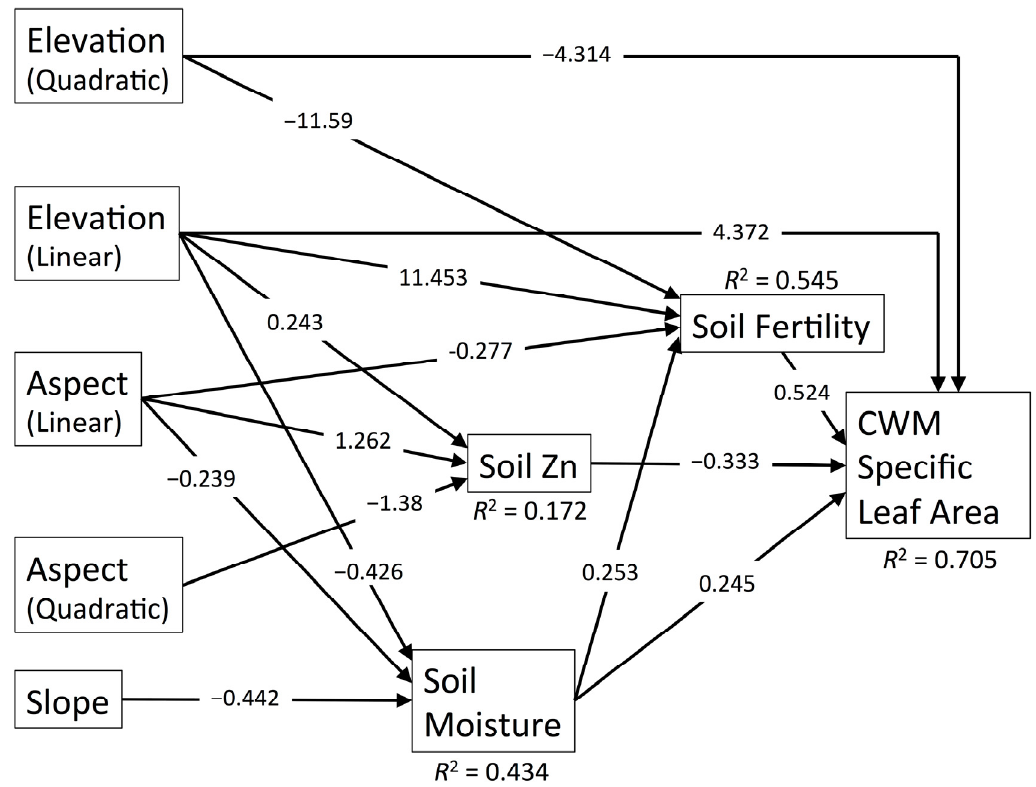
Figure 4. Path diagram for community-weighted mean specific leaf area. Standardized path coefficients are given. R 2 values are total explained variance.